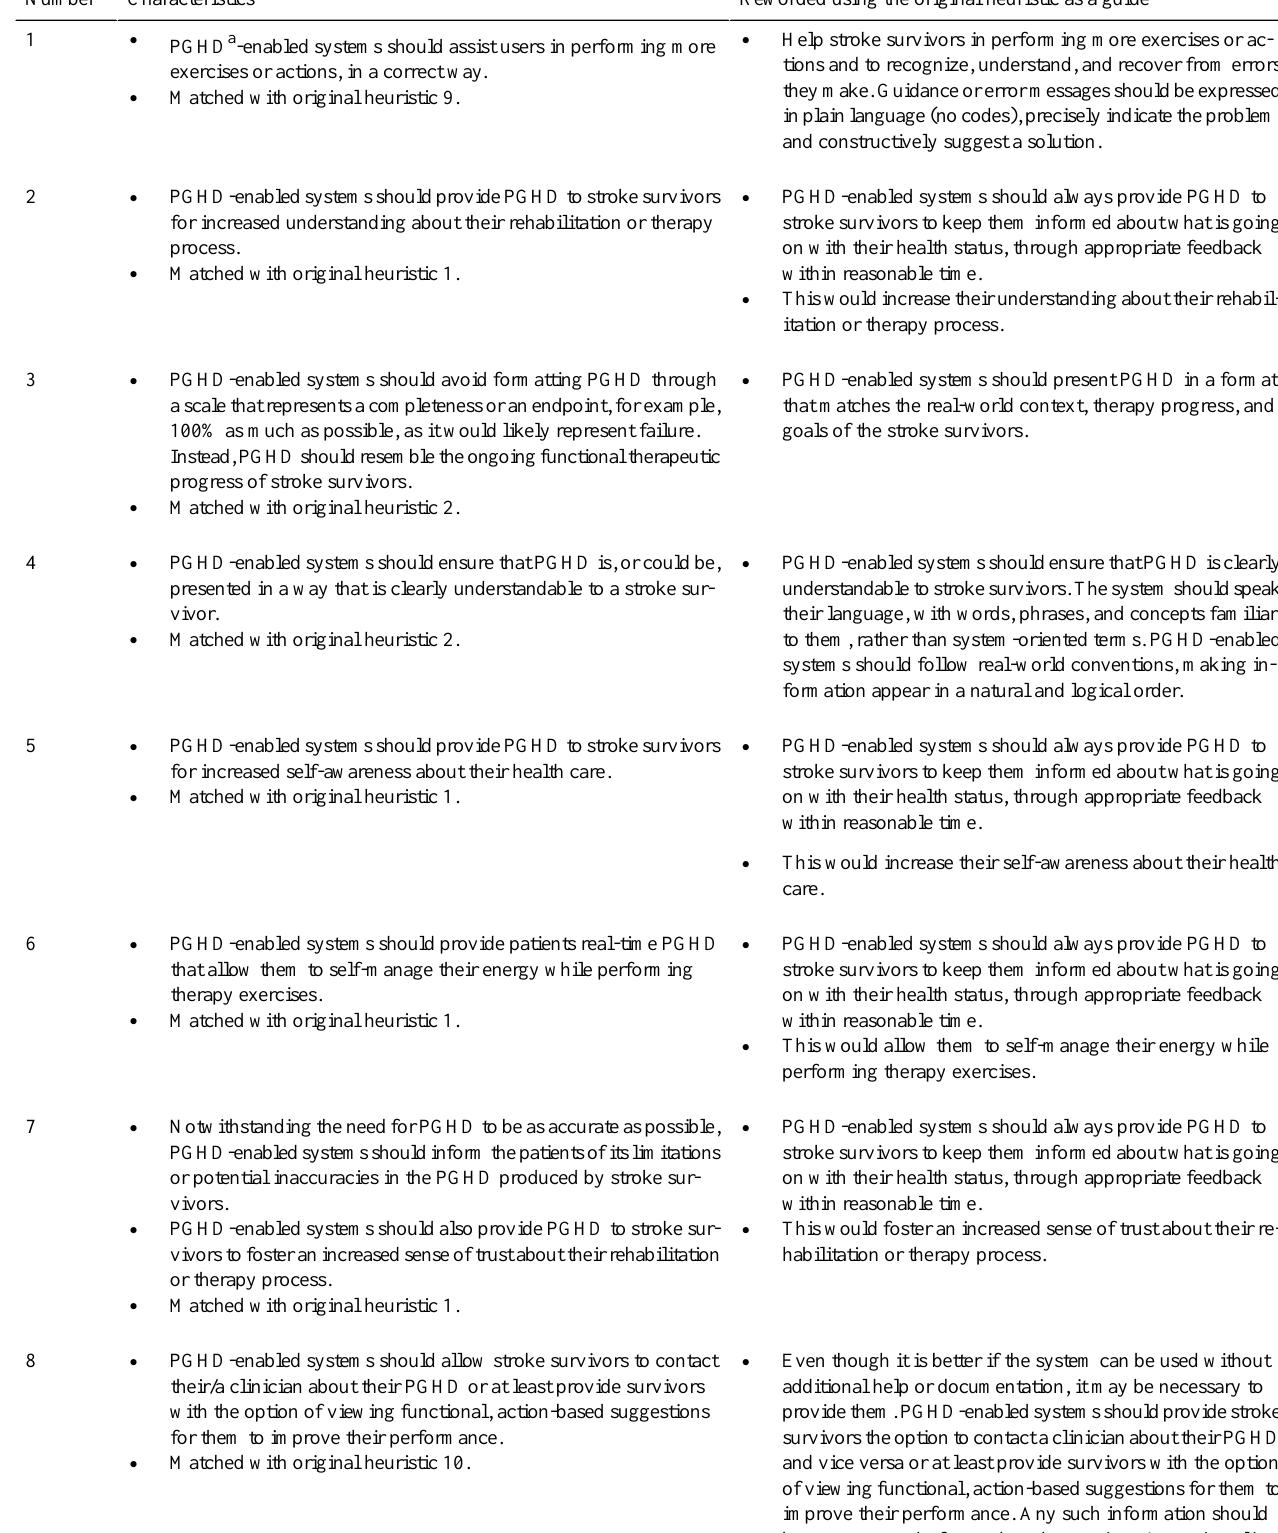
Reworded using the original heuristic as a guideCharacteristicsNumber • Help stroke survivors in performing more exercises or ac- tions and to recognize, understand, and recover from